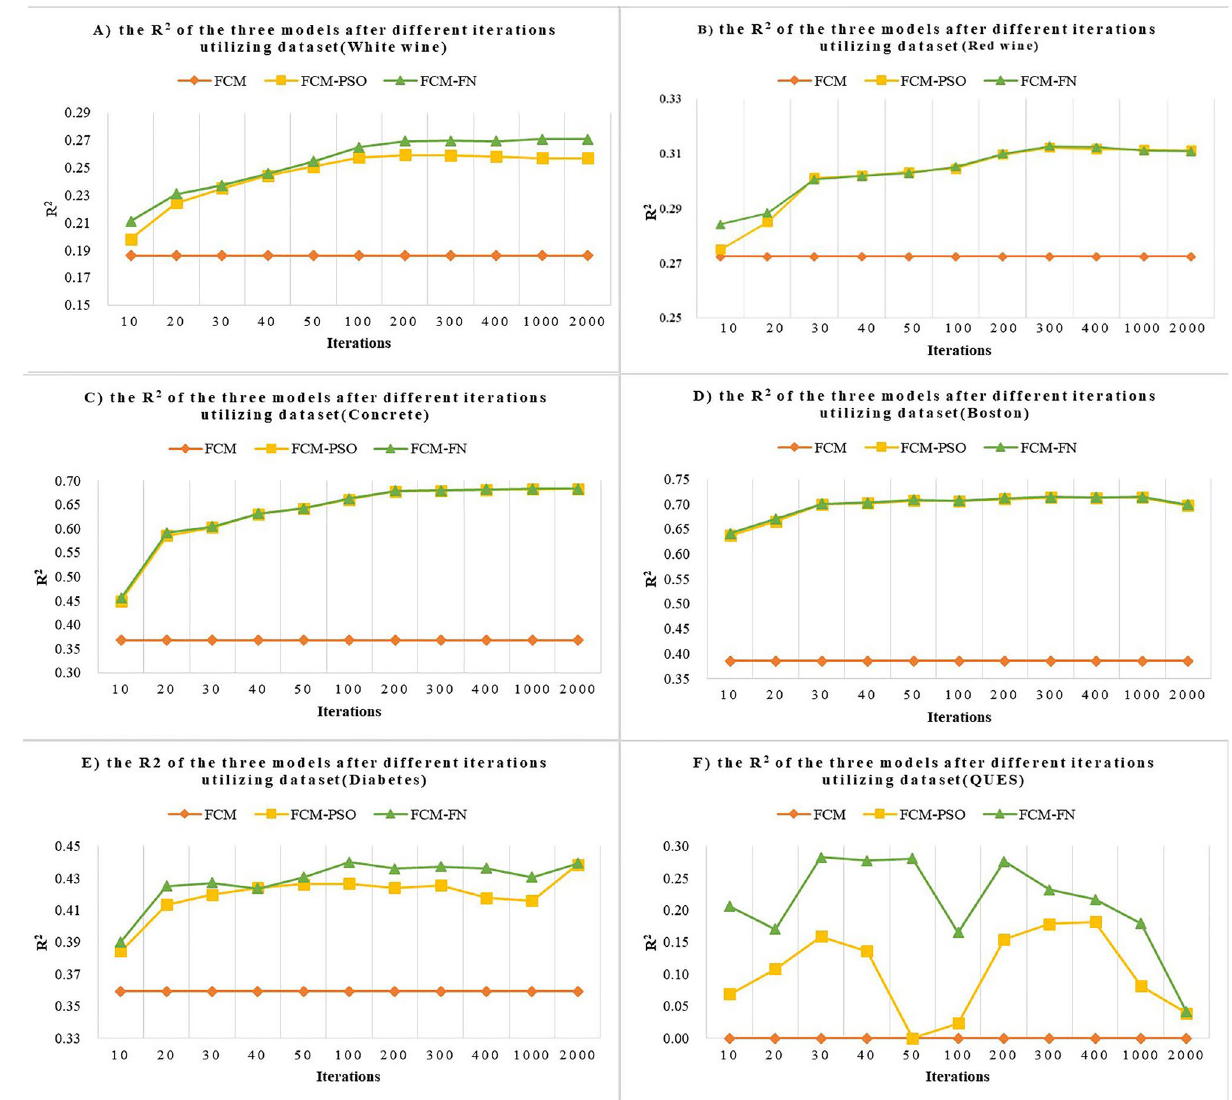
Figure 11. The R 2 of the three models after different iterations’